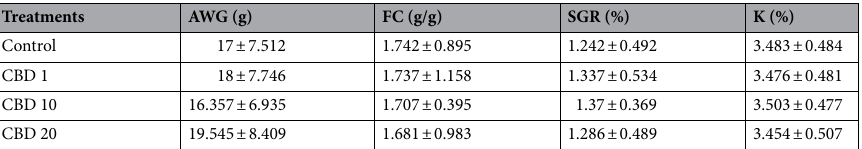
Table 2. Growth response variables of Niles tilapias fed during 28 days with diets containing different cannabidiol (CBD) doses. The absence of asterisks indicates there is no significant difference between the treatments under one-way ANOVA or Kruskal–Wallis tests. Values are mean ± SD (n = 15). No significant differences between the treatments under one-way ANOVA or Kruskal–Wallis tests. AWG average weight gain, FC feed conversion, SGR specific growth rate, K condition factor, CBD